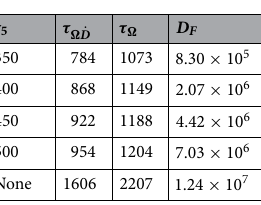
Table 2. Viral extinction dates and total fatalities as a function of day of final protective intervention, for scenarios in Fig.